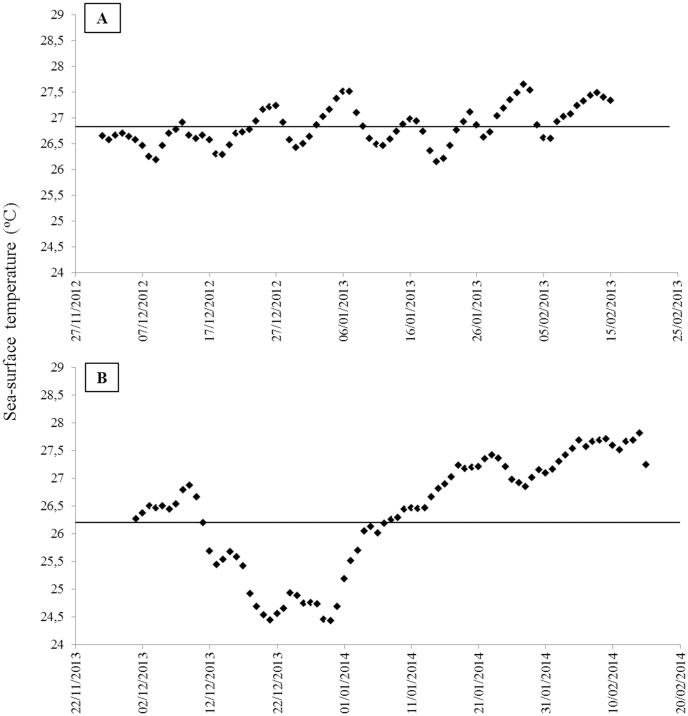
Daily mean sea-surface temperatures during December and January in Abrolhos Archipelago.A) 2012–2013, B) 2013–2014. Solid lines represent the mean summer temperature in both years.